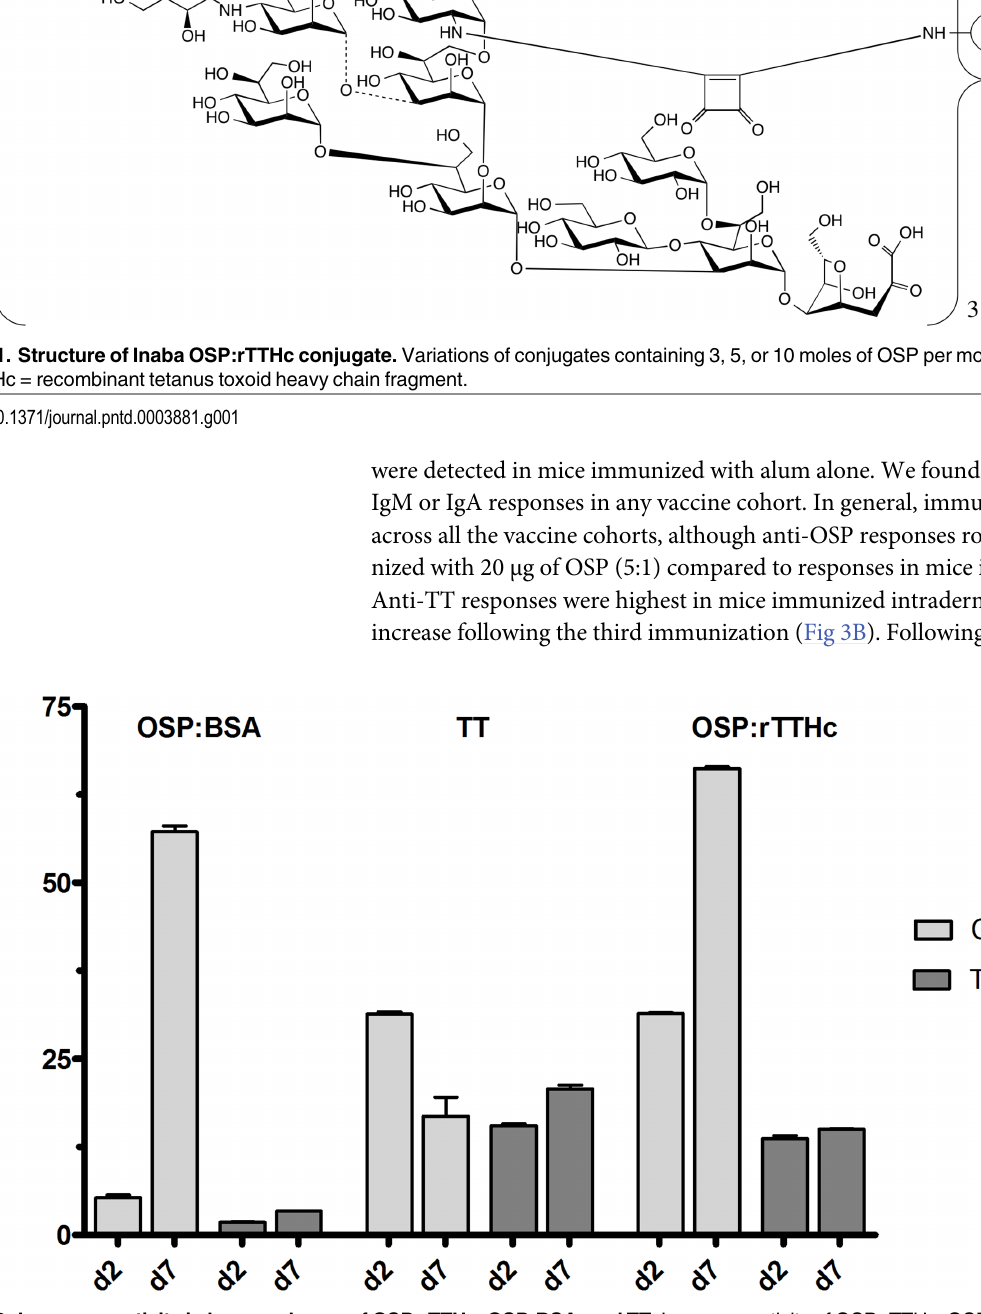
Fig 2. Immunoreactivity in human plasma of OSP:rTTHc, OSP:BSA, and TT. Immunoreactivity of OSP:rTTHc, OSP:BSA and TT was measured in day 2 versus day 7 plasma of patients with cholera versus typhoid fever in Dhaka, Bangladesh.